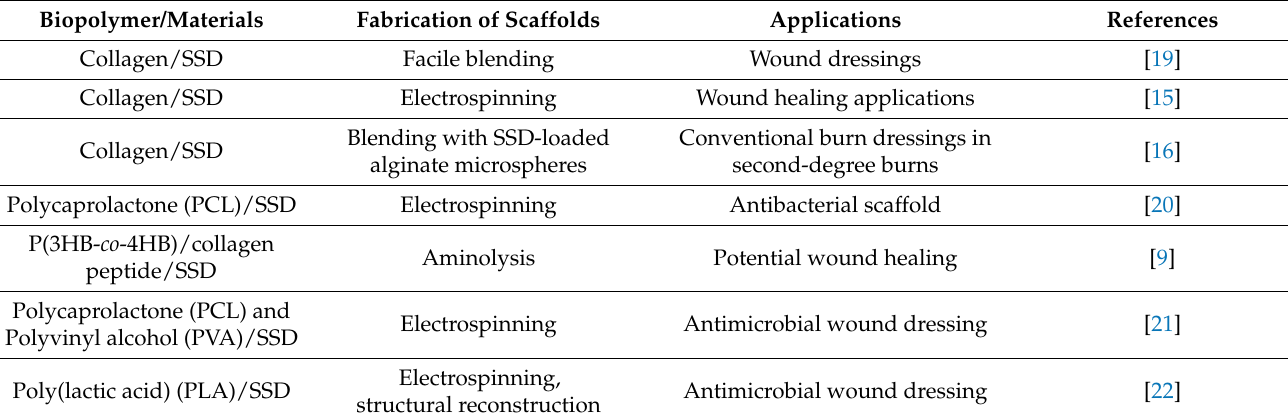
Table 1. List of common examples of various antimicrobial scaffolds incorporated with SSD.